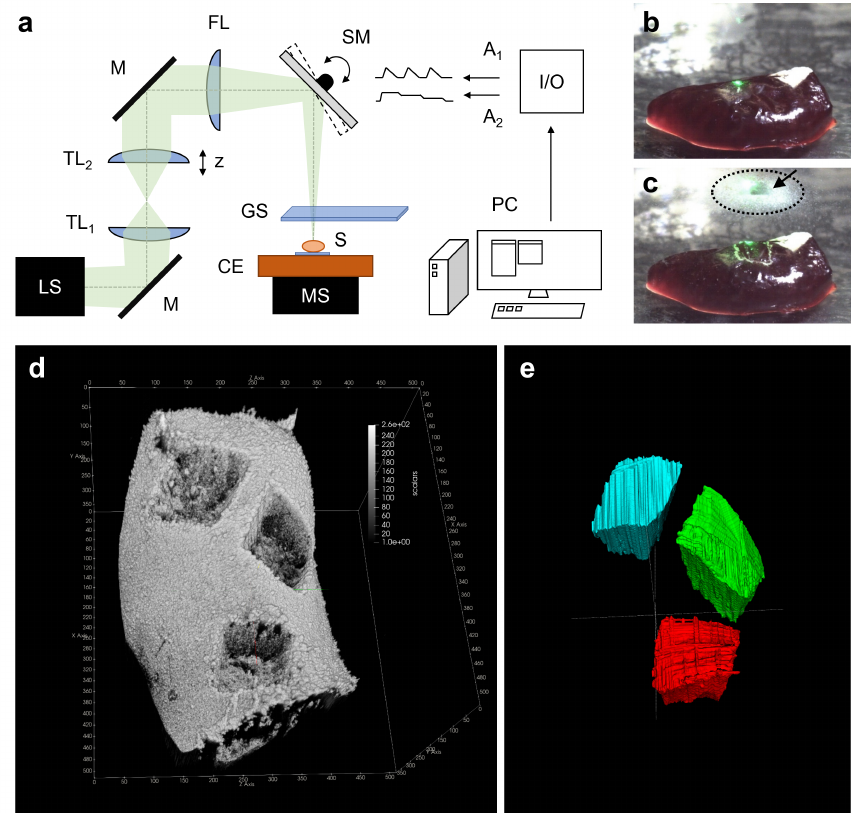
Figure 1. ( a ) Schematic of the ablation setup. Green: divergent beam; LS: NIRL laser system; M: silver mirror; TL 1 , TL 2 : telescope lenses; FL: focusing lens (of 150 mm focal length); SM: two-axis scanning mirror; S: scanning of the sample; MS: manual stage; CE: cooling element ( − 15 °C); I/O: input/output card; A 1 , A 2 : analog control signals; PC: computer. GS: glass cover slip; ( b , c ) Photos of the tissue before and after irradiation; ( c ) Dashed ellipse: Condensed tissue aerosol. Arrow: indicating an area of lost condensate. Green light: pilot laser (532 nm wavelength); ( d ) Rendered 3D OCT image of the reference ablations on formalin-fixed murine spleen for ablation volume measurement purposes with the open-source application ParaView 5.9.1 [27]; ( e ) Manually segmented ablation volumes (with the labels red, blue, green) in the open-source software ITK-Snap 3.8.0